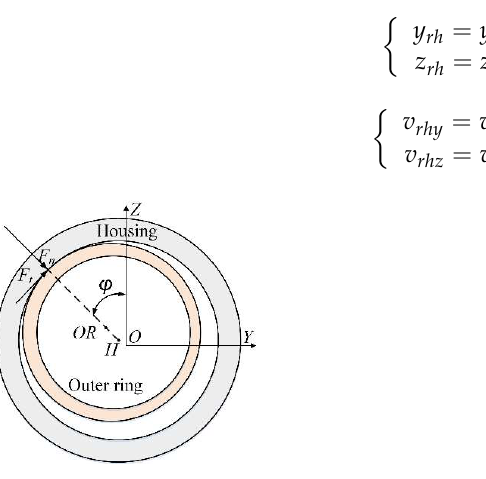
Figure 2. Interaction between outer ring and housing.